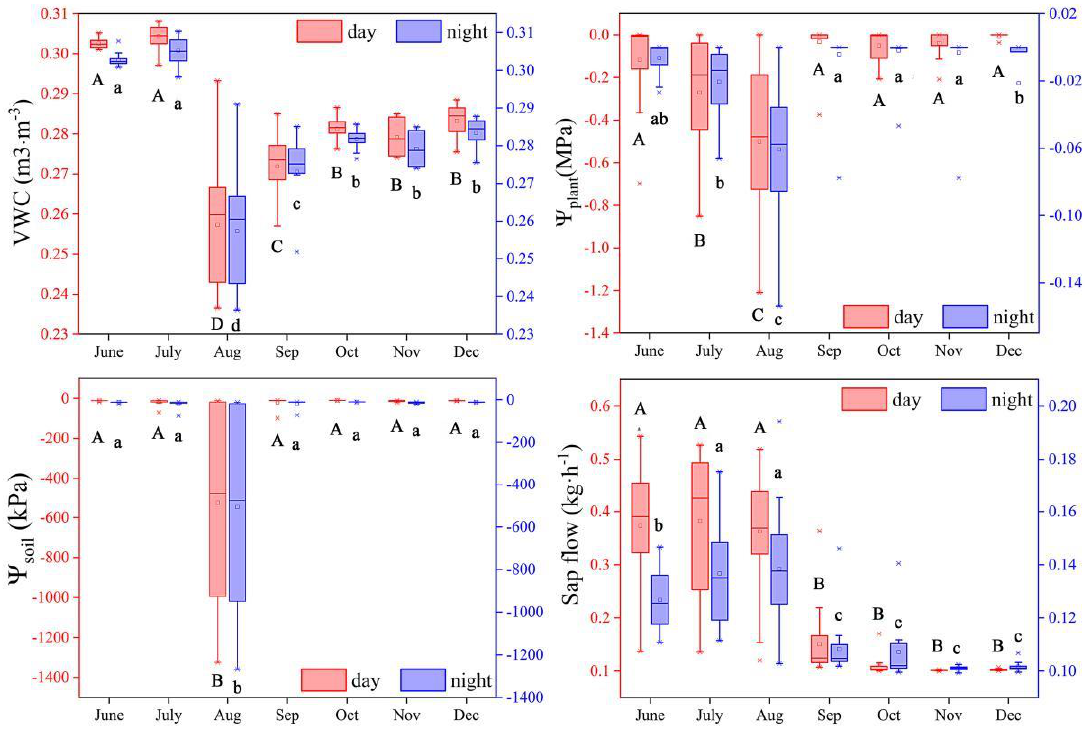
Figure 10. The seasonal changes of VWC, Ψ soil , Ψ plant and sap flow during the whole monitoring period. The red rectangle represents day, and the blue rectangle represents night. Uppercase letters indicate significant differences at the p = 0.01 level, and lowercase letters indicate significant differences at the p = 0.05 level.